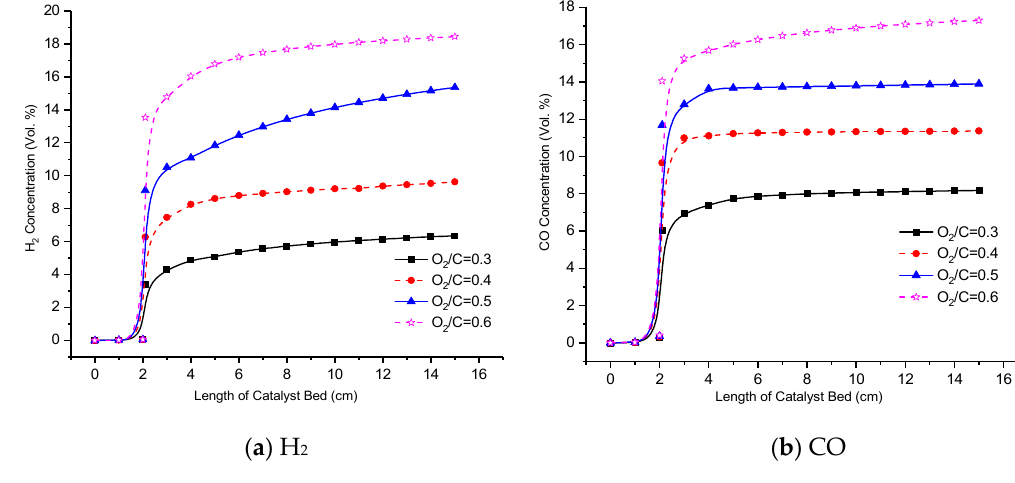
Figure 6. O 2 / C ratio e ff ect on H 2 and CO Figure 6. O 2 /C ratio effect on H 2 and CO concentration.